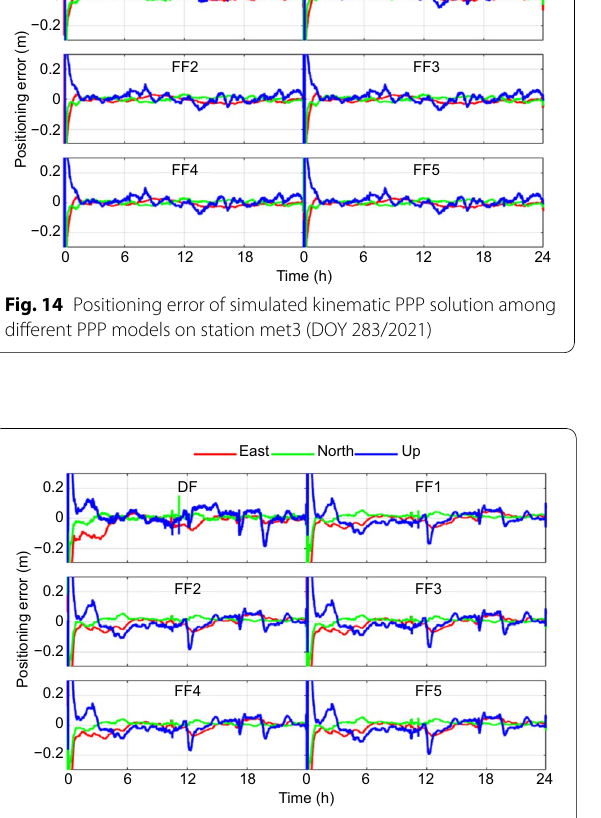
Fig. 15 Positioning error of simulated kinematic PPP solution among different PPP models on station urum (DOY 283/2021)